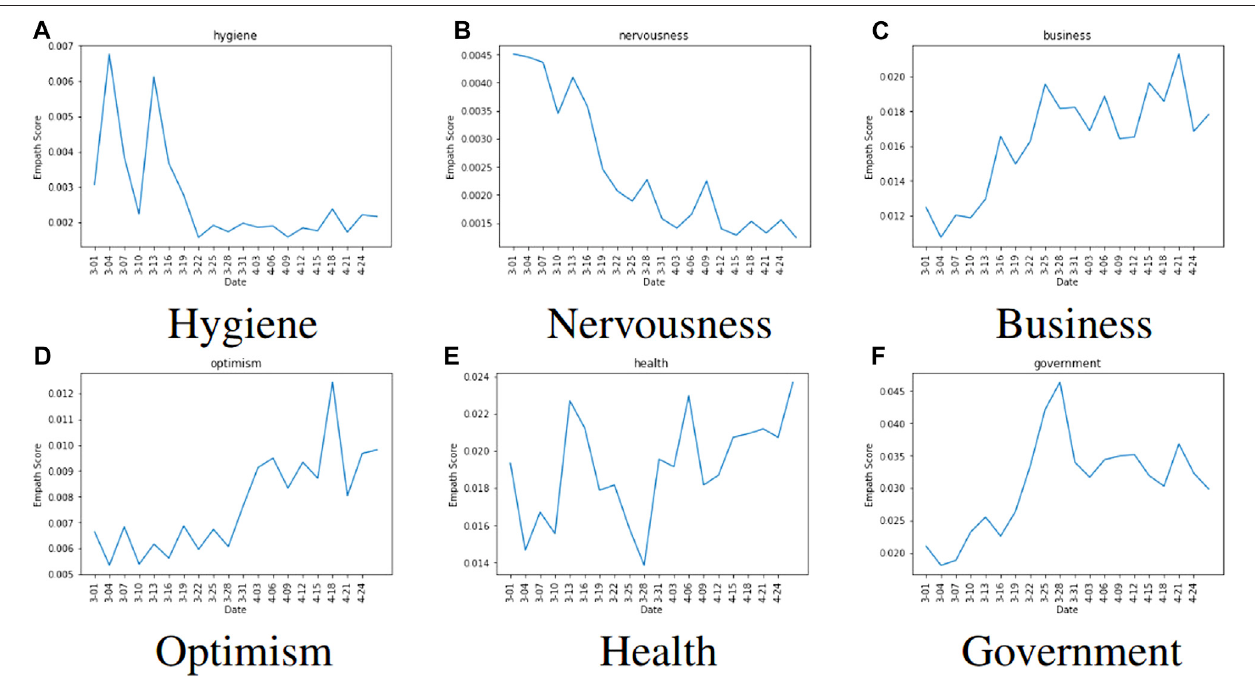
FIGURE 5 | Time Series analysis of emotions in India-related Tweets. Clear patterns of consistent decline/increase can be seen in the time series plots of various emotions, which correlate to on ground events related to COVID-19.